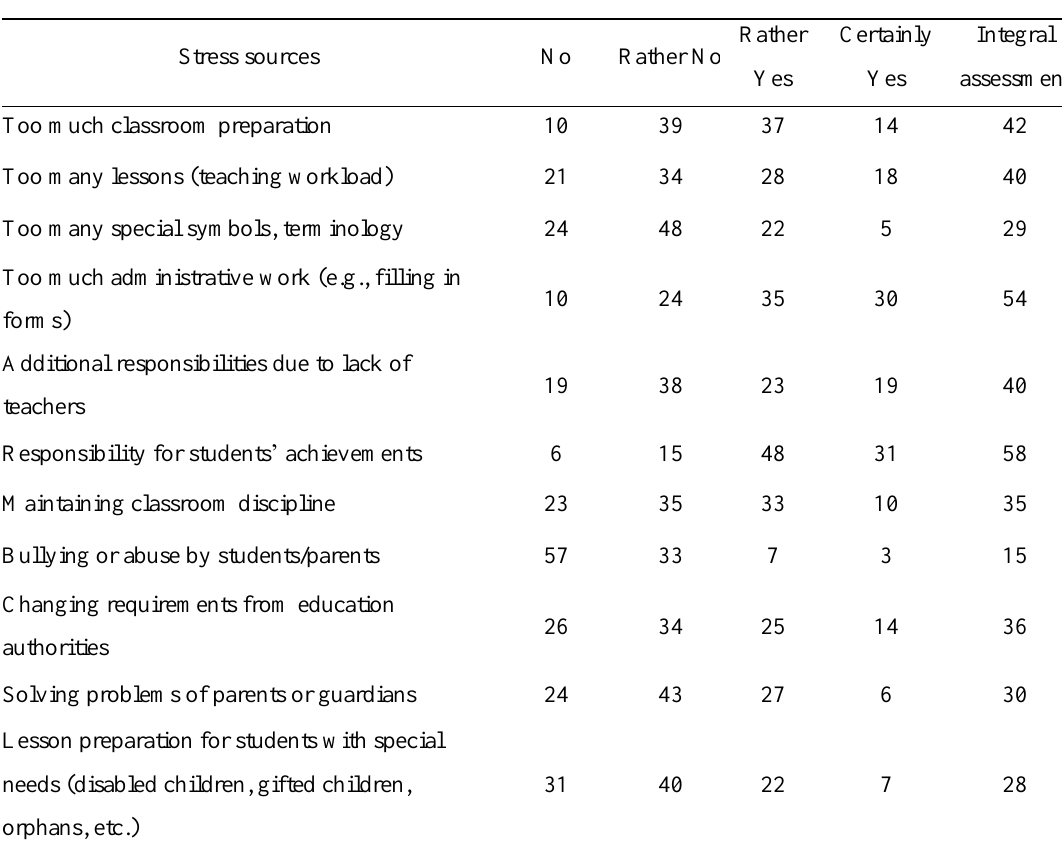
Table 4. Sources of stress in the school,